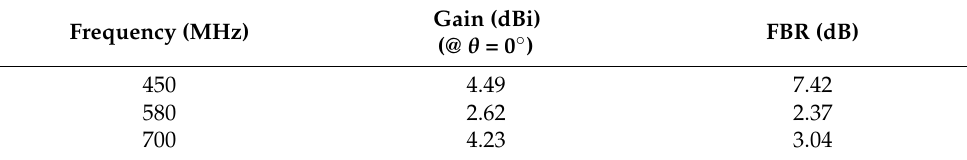
Figure 9. Half bow-tie dipole antenna: ( a ) geometry of antenna with various d 1 values, ( b ) simulated reflection coefficient performances for various d 1 values, ( c ) geometry of antenna with various d 2 values ( d 1 = 20 mm), ( d ) simulated reflection coefficient performances for various d 2 values ( d 1 = 20 mm), ( e ) simulated E-field distribution at 677 MHz when d 1 = 20 mm and d 2 = 6 mm, ( f ) simulated radiation performances versus frequency when d 1 = 20 mm and d 2 = 6 mm, ( g ) simulated radiation patterns at 450 MHz when d 1 = 20 mm and d 2 = 6 mm, ( h ) simulated radiation patterns at 580 MHz when d 1 = 20 mm and d 2 = 6 mm, and ( i ) simulated radiation patterns at 700 MHz when d 1 = 20 mm and d 2 = 6 mm. Table 4. Simulated radiation performances when d 1 = 20 mm and d 2 = 6